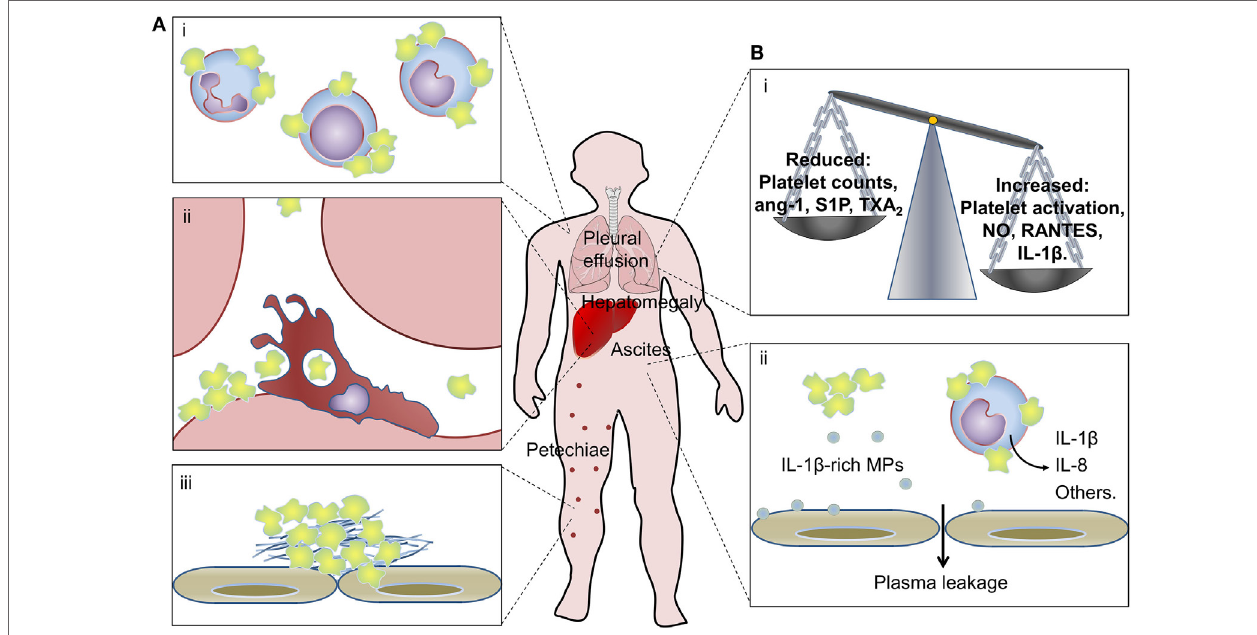
FigURe 3 | Platelets in dengue pathogenesis. (A) Peripheral mechanisms of thrombocytopenia in dengue: (i) platelet–leukocyte aggregates are formed with monocytes, lymphocytes, and neutrophils in the circulation of dengue patients; (ii) increased platelet sequestration in the liver of patients with dengue hemorrhagic fever/dengue shock syndrome and clearance of apoptotic platelets by resident macrophages through phosphatidylserine-mediated phagocytosis; and (iii) platelet adhesion and platelet clot formation on microvascular bed at the periphery may all contribute to thrombocytopenia in dengue. (B) Contributions of platelet activation and thrombocytopenia to inflammatory amplification and increased vascular permeability in dengue: (i) thrombocytopenia and reduced levels of platelet-derived endothelium-stabilizing factors alongside increased production of pro-inflammatory vasoactive factors by activated platelets that remain in circulation may contribute to dengue-associated vasculopathy; (ii) platelet synthesis of IL-1 β and release of IL-1 β -containing microparticles (MPs) associate with increased vascular permeability in dengue patients, and IL-1- β -rich MPs shed from dengue virus-infected platelets increase endothelial permeability in vitro ; activated platelets from dengue-infected patients also induce pro-inflammatory cytokine secretion by monocytes. See the text for details and